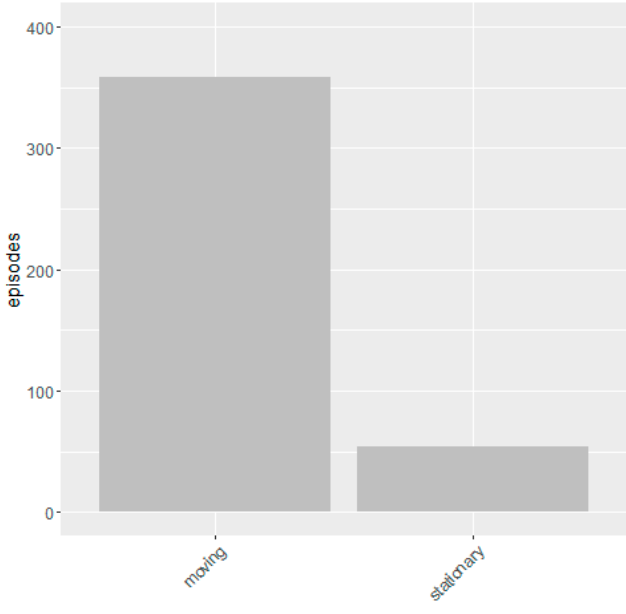
Figure 6. Episodes of movement and stationary activity observed.